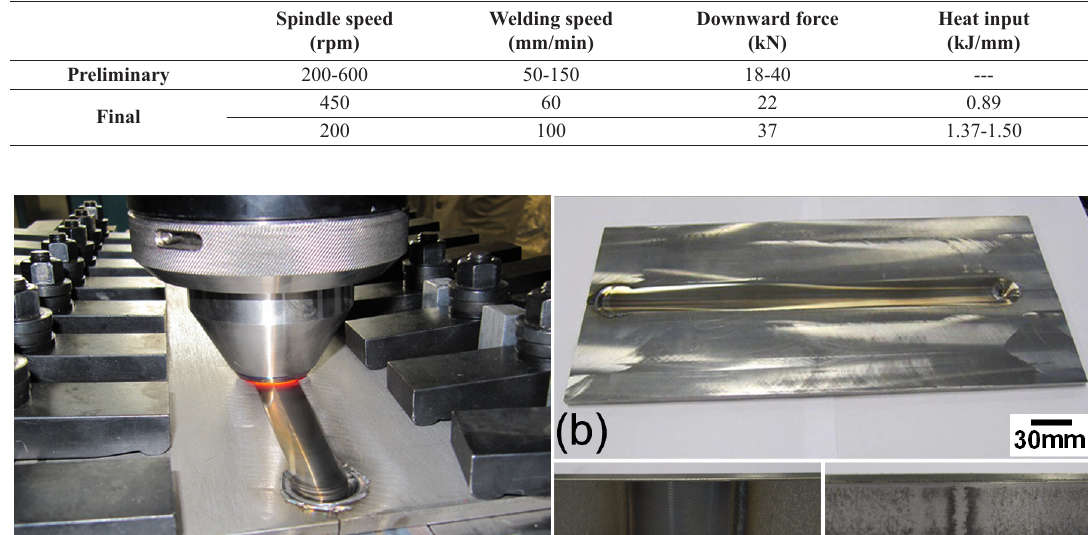
Table 2. Preliminary and final welding parameters and the resulting heat inputs in the final